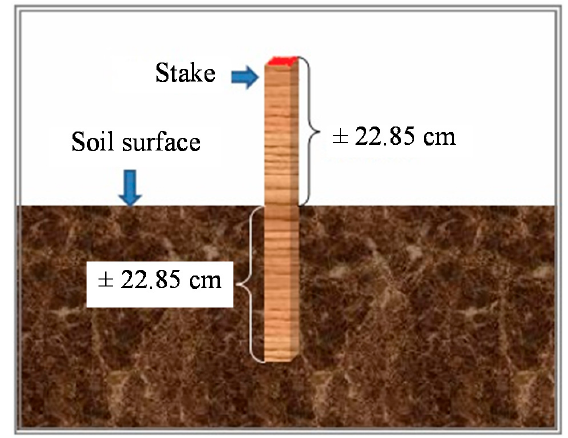
Figure 1. Installation of stakes.